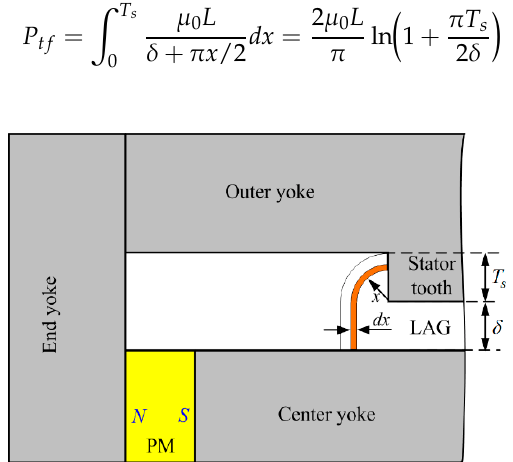
Figure 5. A circular-arc straight-line permeance model of tooth-to-center-yoke flux leakage.